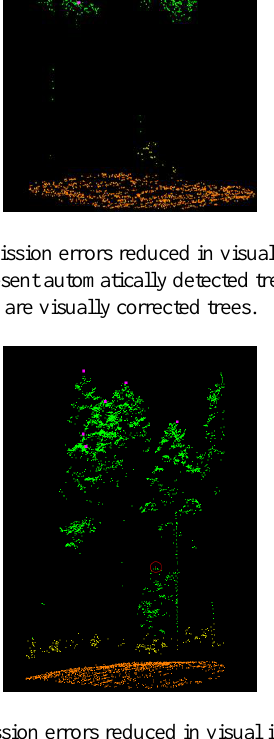
Figure 3. Omission errors reduced in visual interpretation.